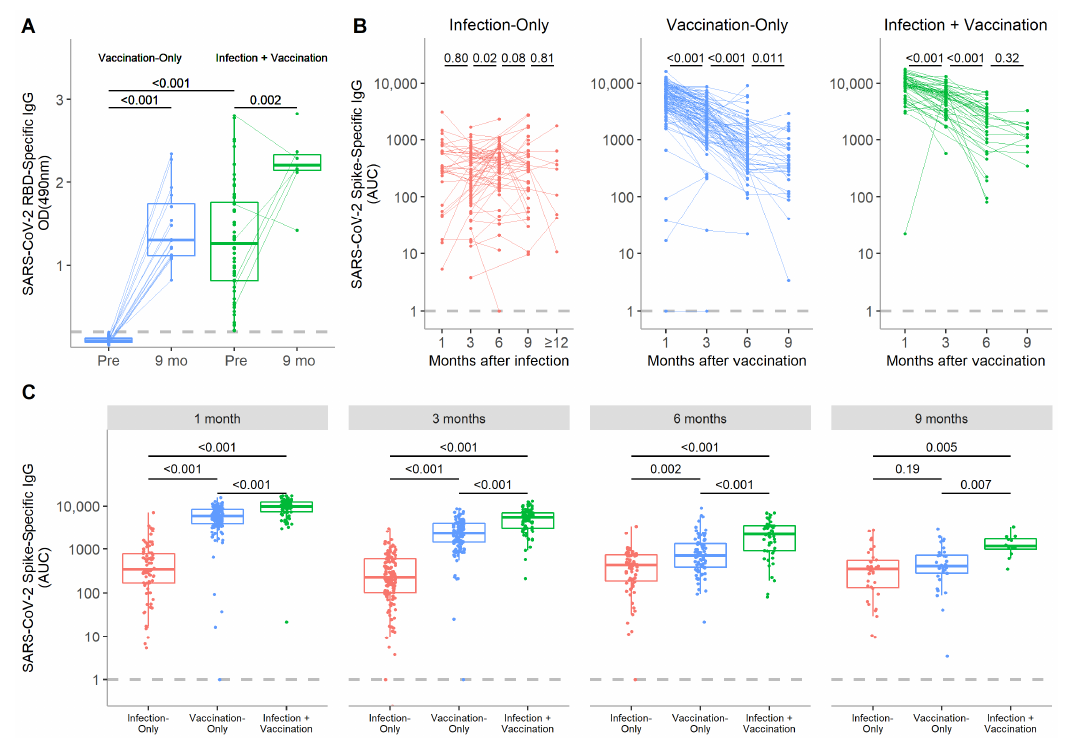
Figure 1. SARS-CoV-2-specific IgG responses over time in the serum following SARS-CoV-2 infection, COVID-19 mRNA vaccination, or both. ( A ) Pre-vaccination levels of RBD-specific IgG in participants in the vaccination-only and infection + vaccination groups are compared with 9 month post-vaccination paired samples. The threshold for positivity was set at 0.200 OD 490 based on levels observed in pre-pandemic samples. ( B ) Longitudinal analyses of spike-specific IgG over time from paired serum samples are displayed for the infection-only, vaccination-only, and infection + vaccination participants. ( C ) The magnitude of the IgG response at each time point is compared among the infection-only, vaccination-only, and infection + vaccination groups. Spike-specific IgG is reported as area under the curve (AUC) with the box as the median and interquartile range and the whiskers as the minimum and maximum values, excluding outliers. p -values were calculated by Wilcoxon signed-rank tests if between paired time points or the Kruskal − Wallis test followed by Dunn’s multiple comparisons test if between multiple groups.